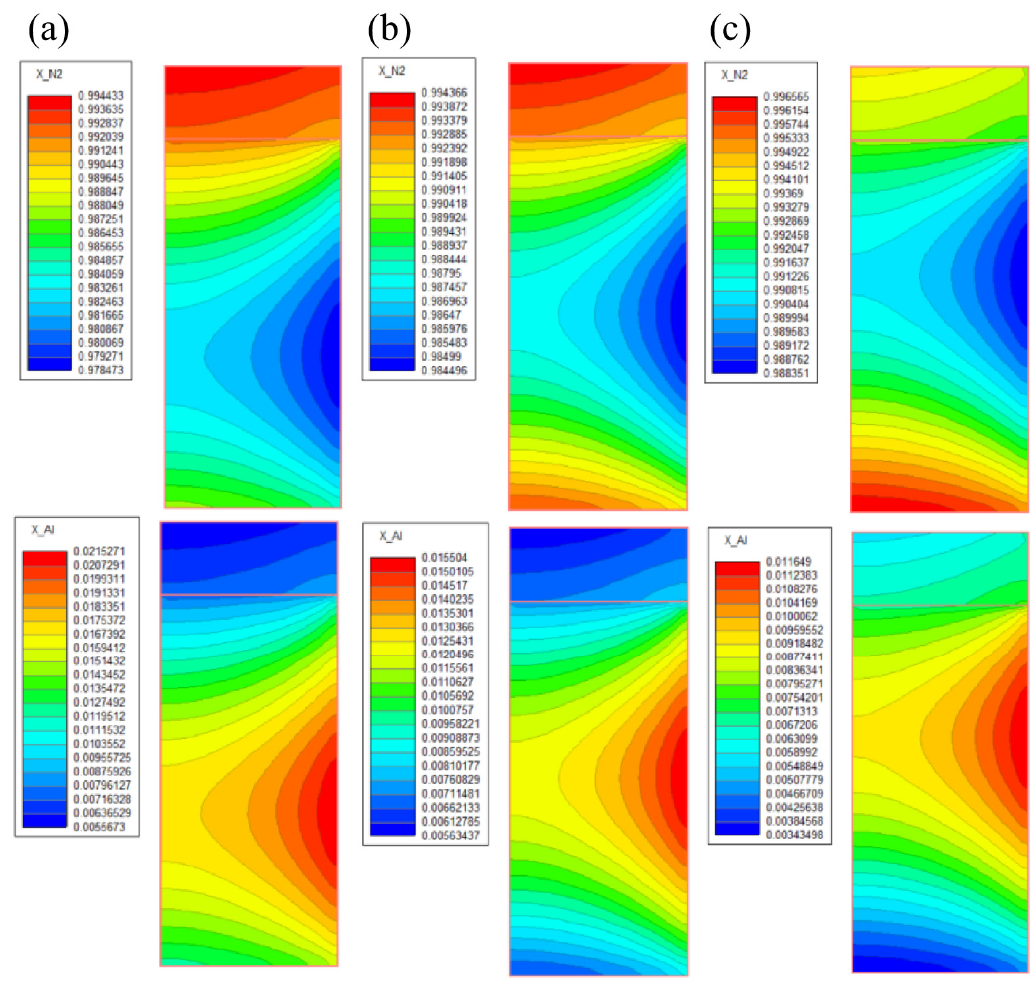
Figure 5. Species distribution ( a ) − 15 mm; ( b ) 0 mm; ( c ) 15 mm. Figure 6 is the growth rate curve corresponding to different positions of the heater.